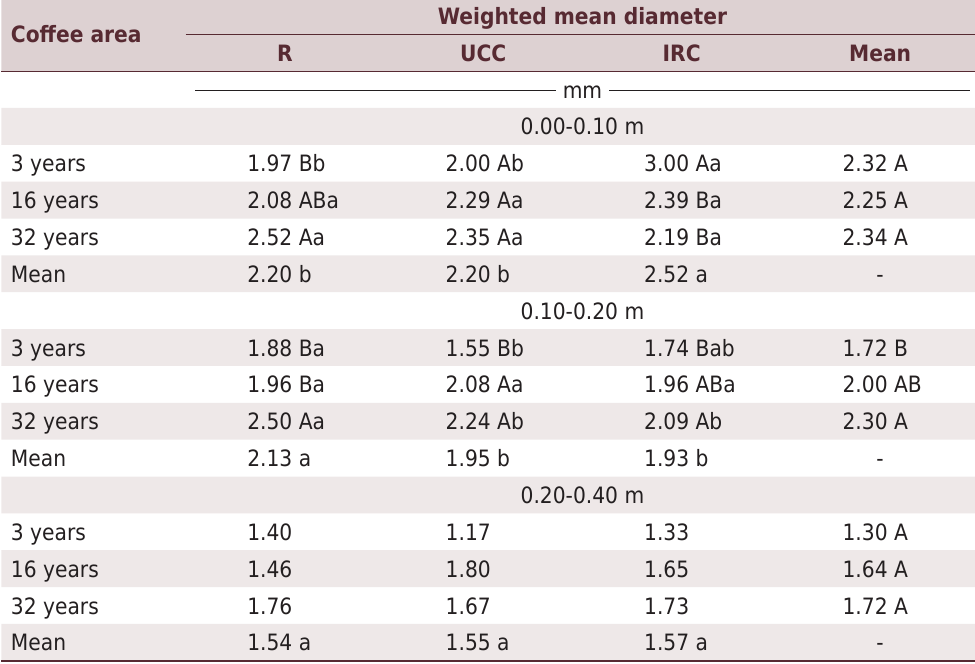
Table 4. The weighted mean diameter of an Ultisol, in areas cultivated with coffee with different deployment times (3, 16, and 32 years), at 0.00-0.10, 0.10-0.20, and 0.20-0.40 m layers,